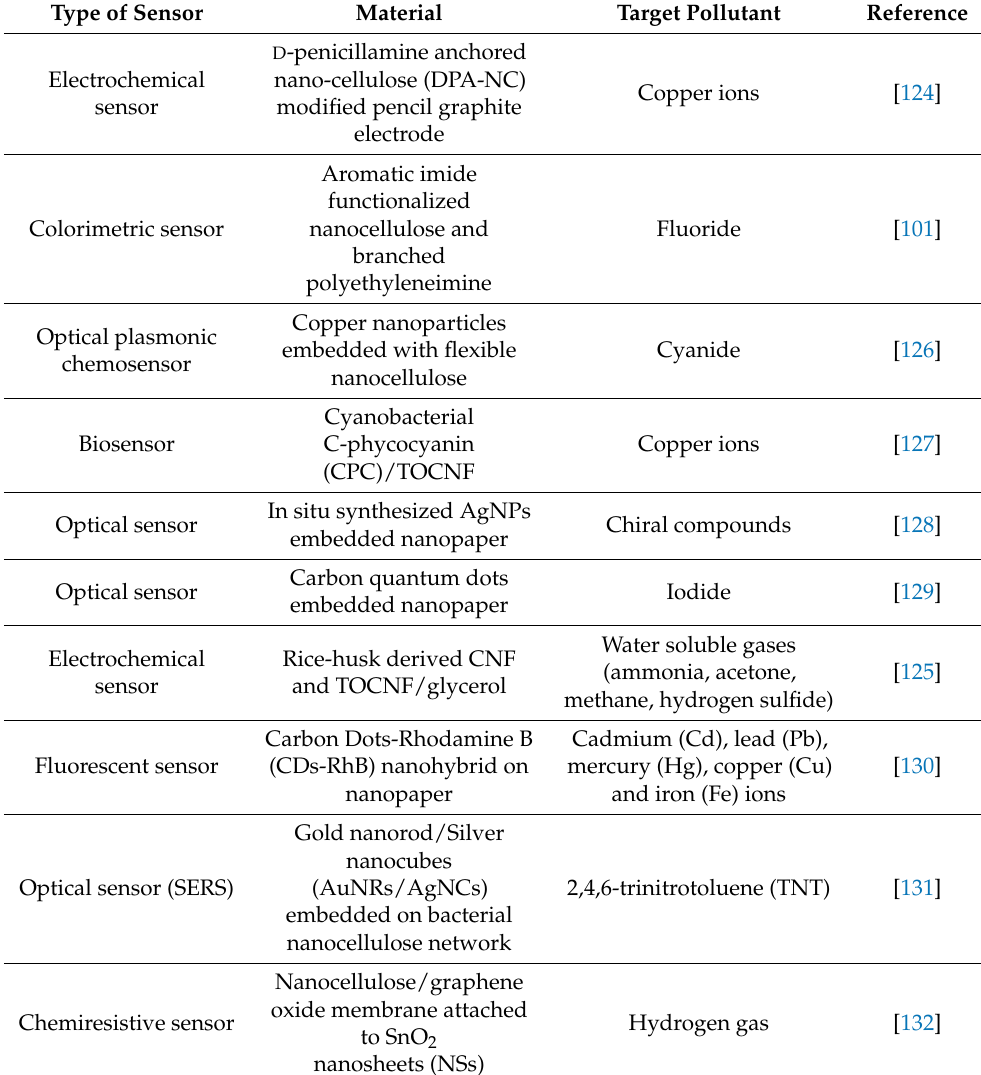
Table 6. Nanocellulose-based pollutant